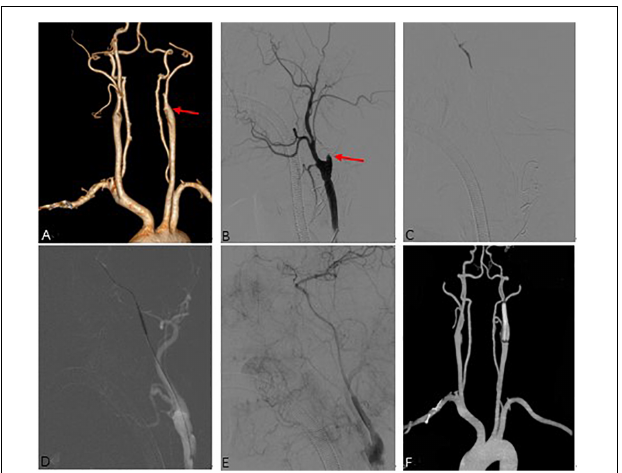
FIGURE 3 | Representative Case 3. A 53-year-old man with right-sided limb weakness underwent hybrid surgery for internal carotid artery occlusion (ICAO). (A) Preoperative computed tomography angiography (CTA) showed left total ICAO (red arrow). Intraoperative angiography showed (B) an artificial stump (red arrow) after carotid endarterectomy and distal true lumen of ICA (C) . Successful recanalization (E) was achieved after balloon expansion (D) and deployment of the stent. (F) CTA showed a patent ICA at 3 months after the